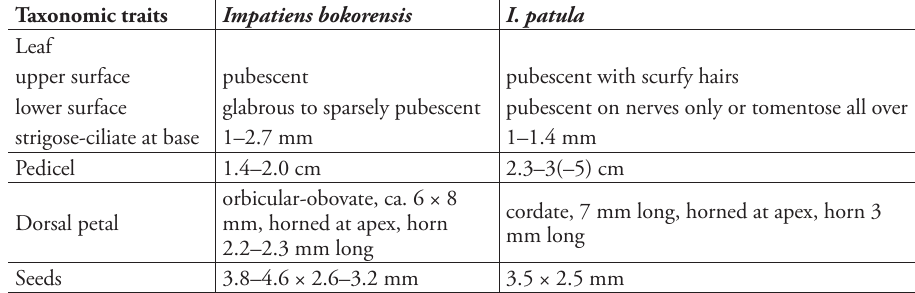
Table 1. Comparison of key features of Impatiens bokorensis and I . patula . Taxonomic